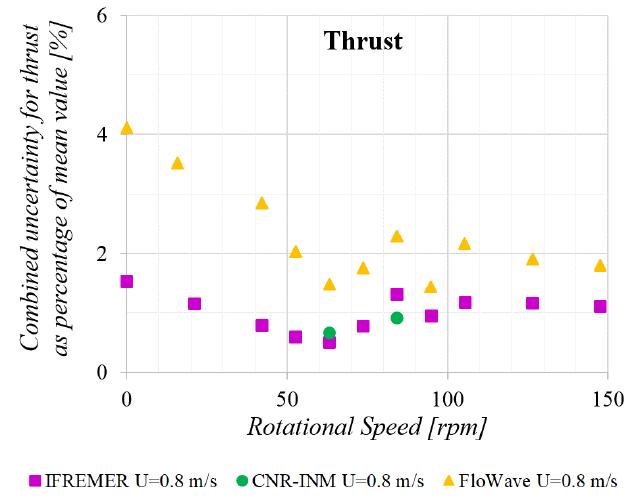
Figure 16. Combined uncertainty for all cases at u = 0.8m/s (i.e., cases 1, 2, 3 and 7) for torque ( top ) and thrust ( bottom ) as percentage of mean value based on the rotational speed for each the